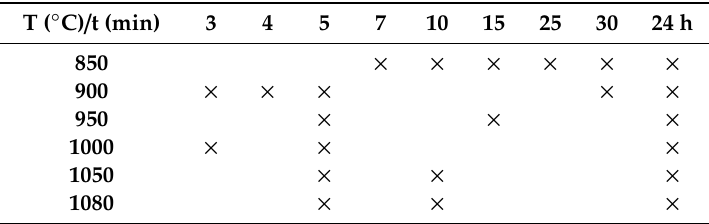
Table 2. Schematic of the heat treatments performed on the investigated